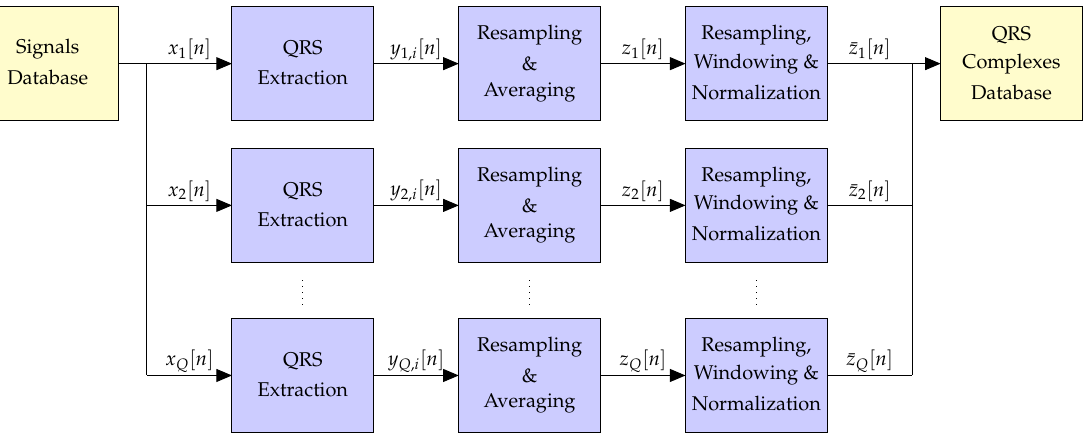
Figure 2. Block diagram of the pre-processing stage applied before the creation of the